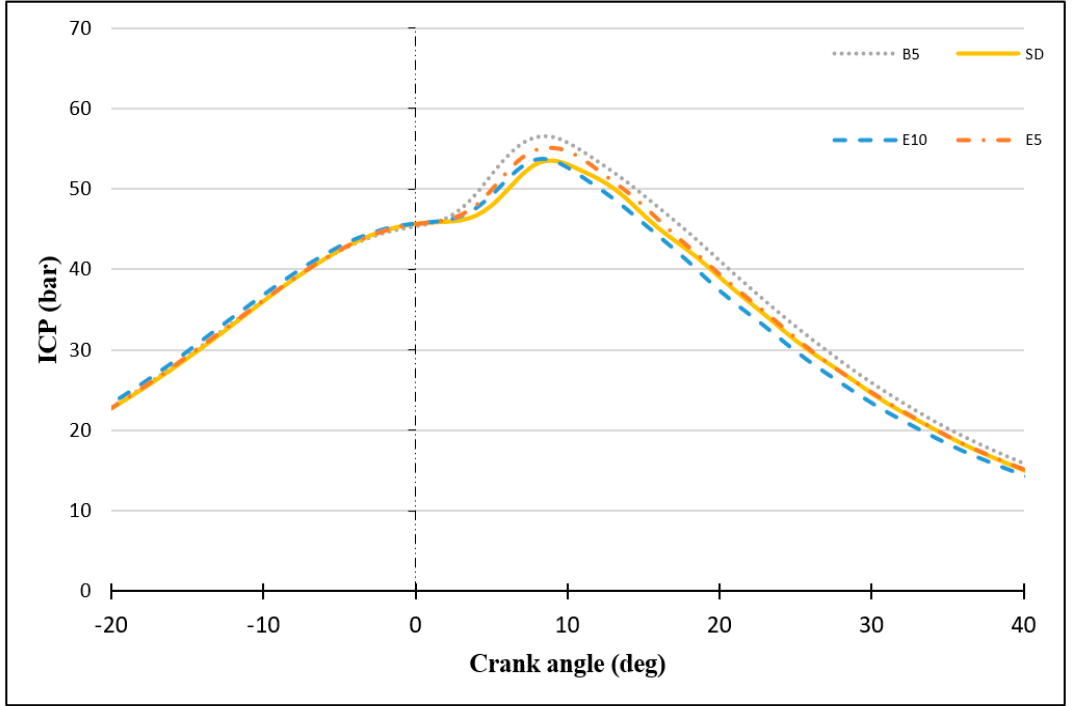
Figure 9. In-cylinder pressure (ICP) traces for B5, E10, E5, and SD at 1 kW.